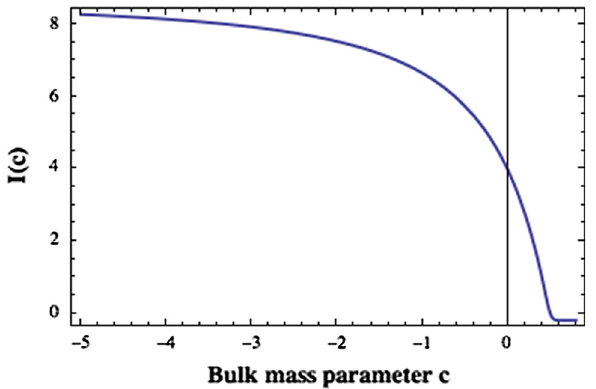
Fig. 11 Overlap integral I as a function of bulk mass parameter